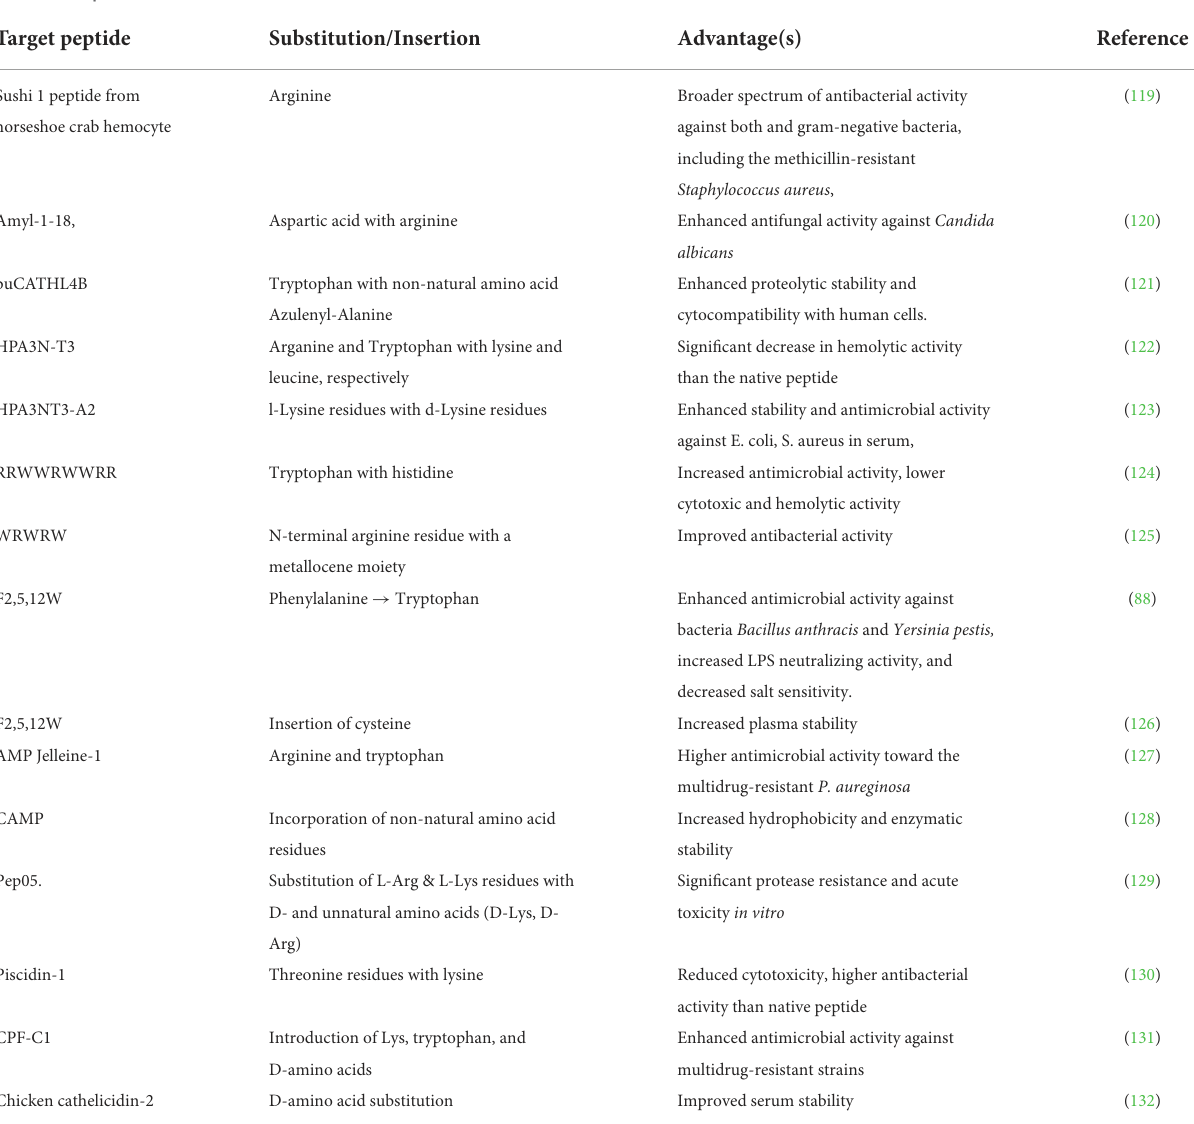
TABLE 3 Peptide modification via amino acid